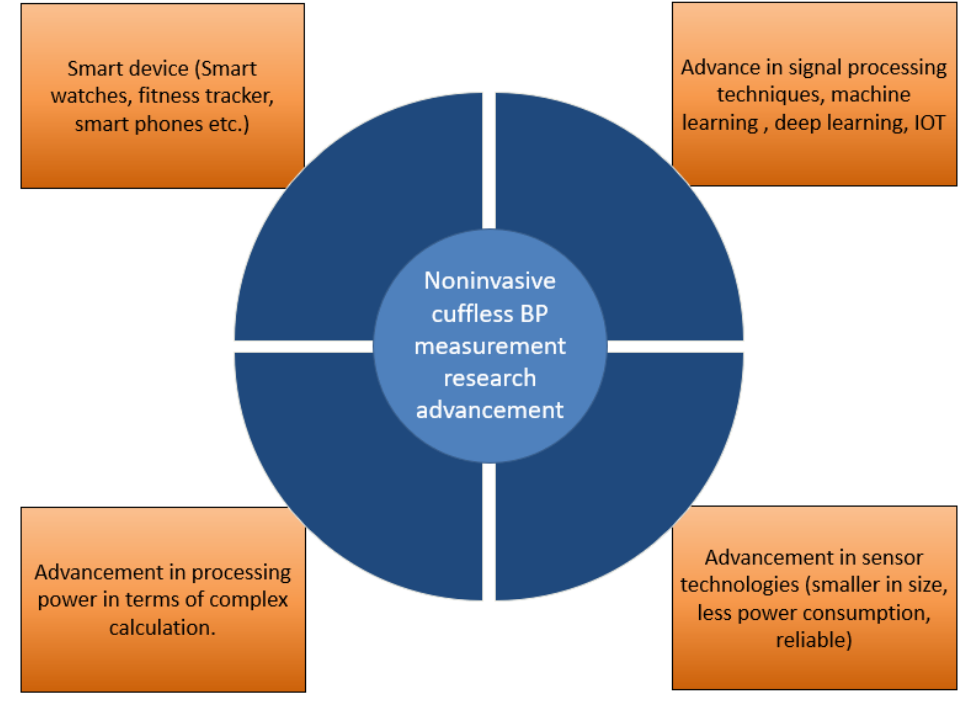
Figure 3. Technological advances behind the research progress in cuffless BP measurement tech-